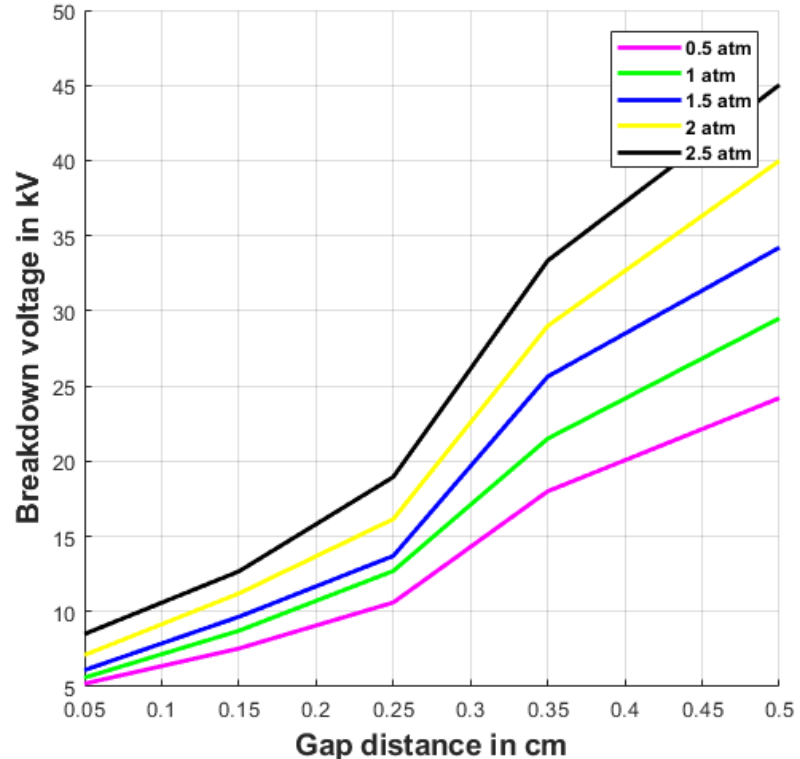
Figure 3. Experimental results for breakdown voltage of R410A as a function of the distance between two spheres electrodes at various gas pressures.